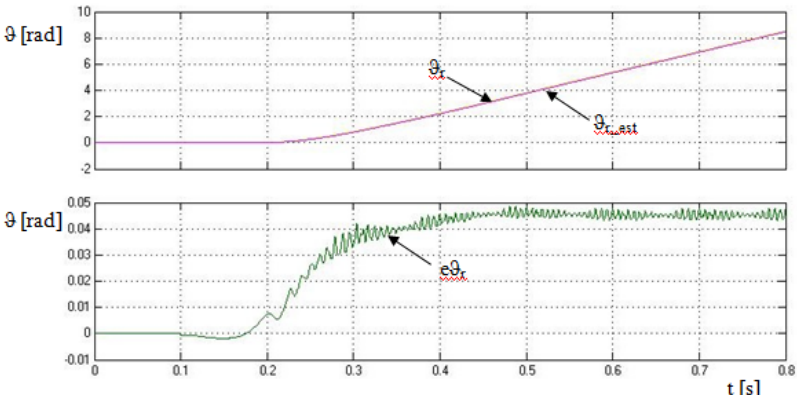
Figure 22. Block diagram of NSDR position estimation .